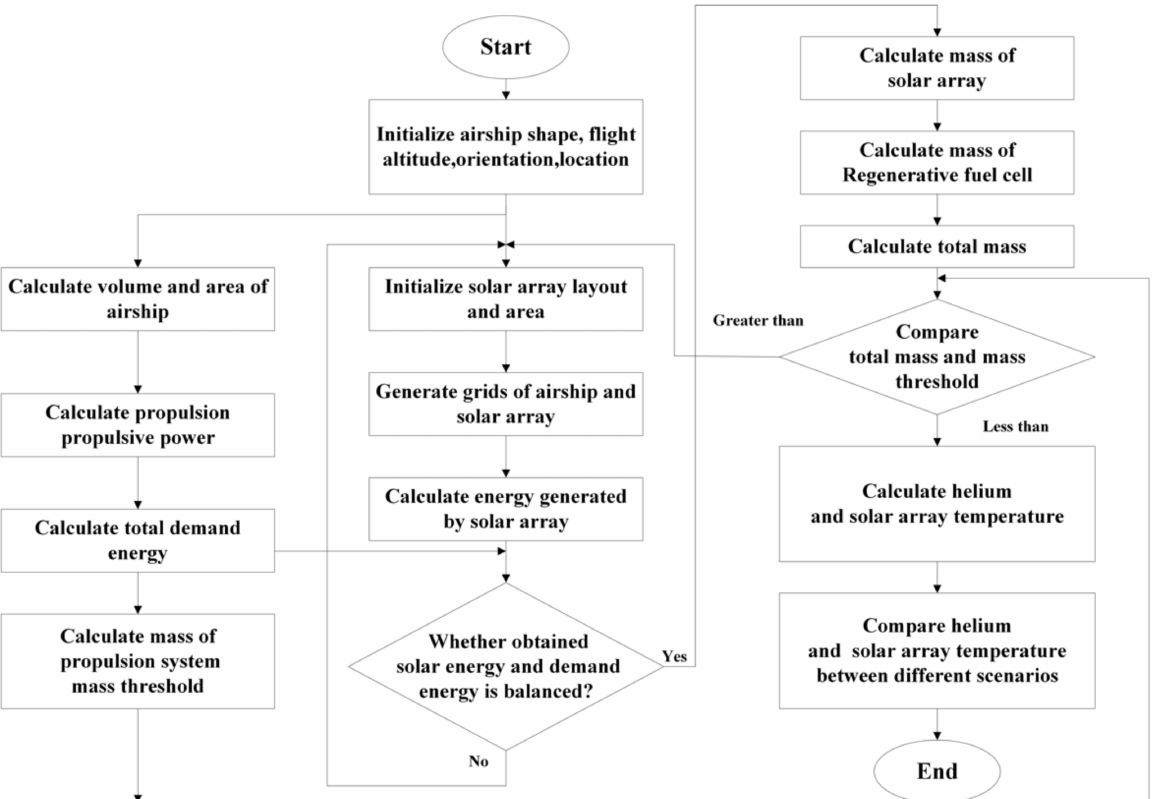
Figure 4. The design process of energy supply system for a